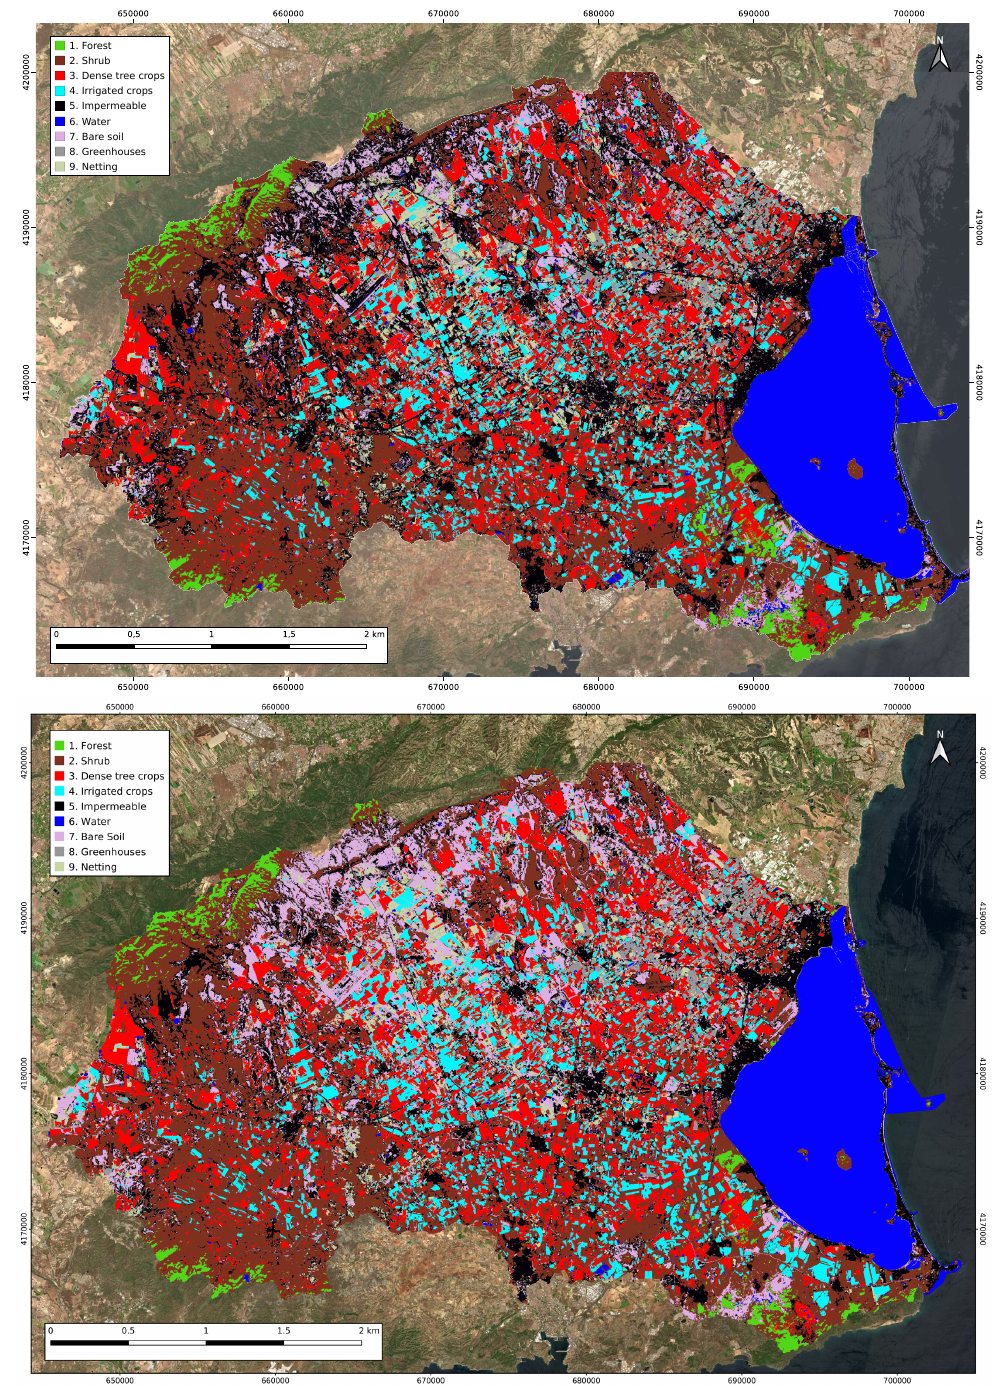
Figure 8. Land cover map obtained with only S2 reflectivities ( above ) and with the final model ( below